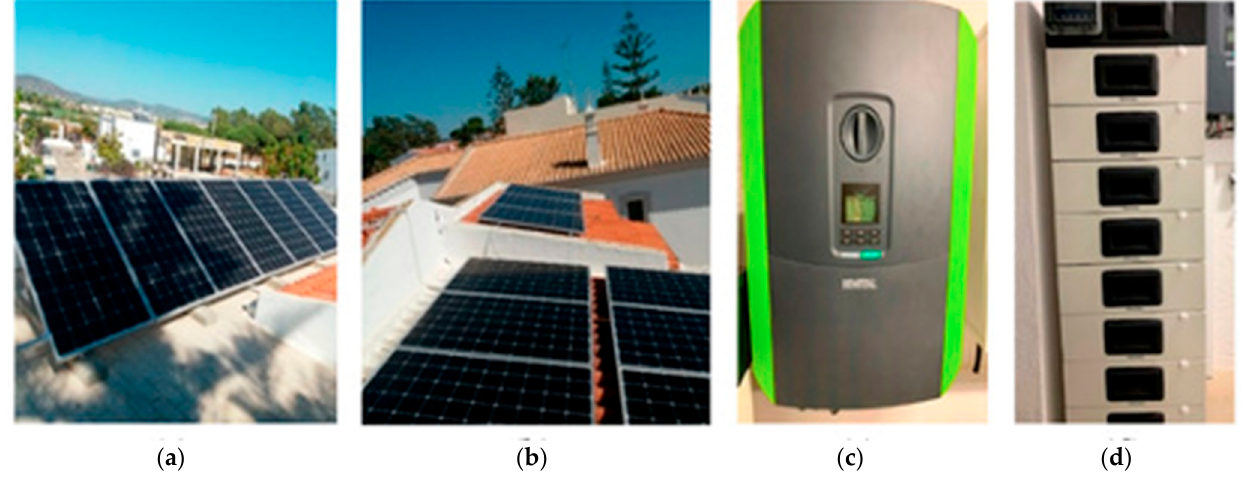
Figure 2. Case study details: ( a , b ) PV system, ( c ) inverter, ( d ) battery system [39] .